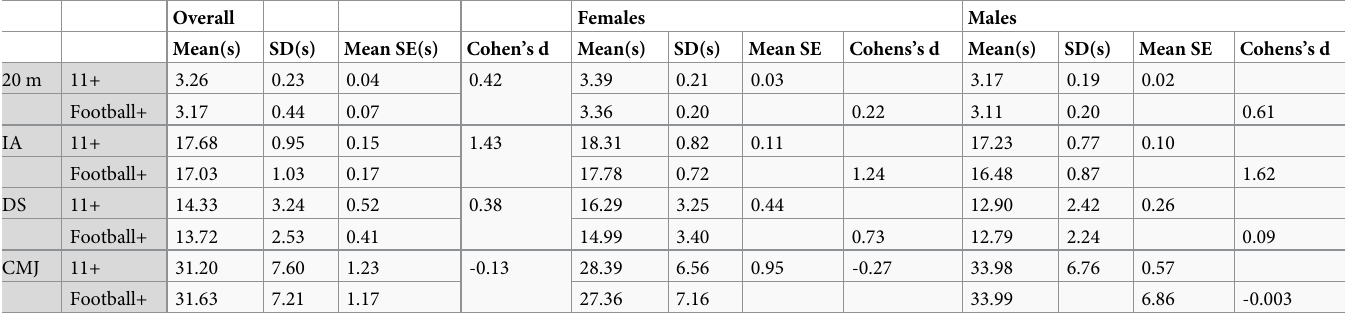
Table 1. Mean values, standard deviation (SD) and mean standard error (mean SE) for the 11+ and Football+.